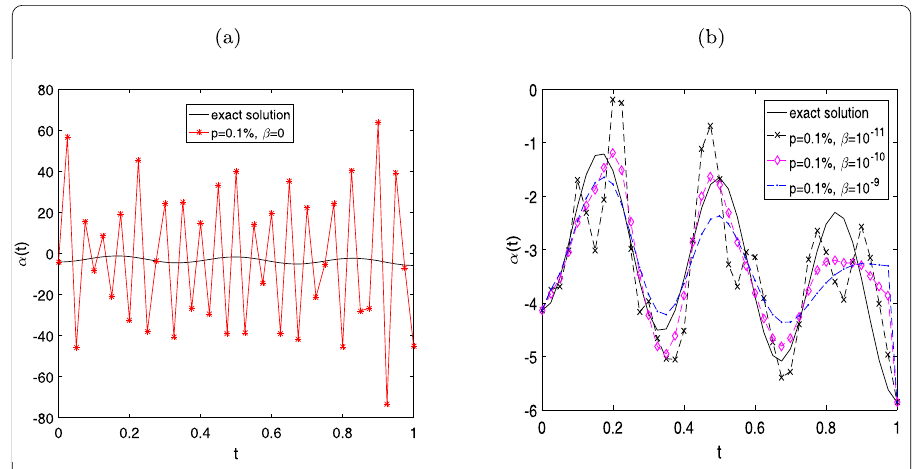
Figure 10 The analytical (43) and approximate α ( t ) with p = 0.1% for β : ( a ) 0 and ( b ) 10 –11 , 10 –10 , 10 –9 for